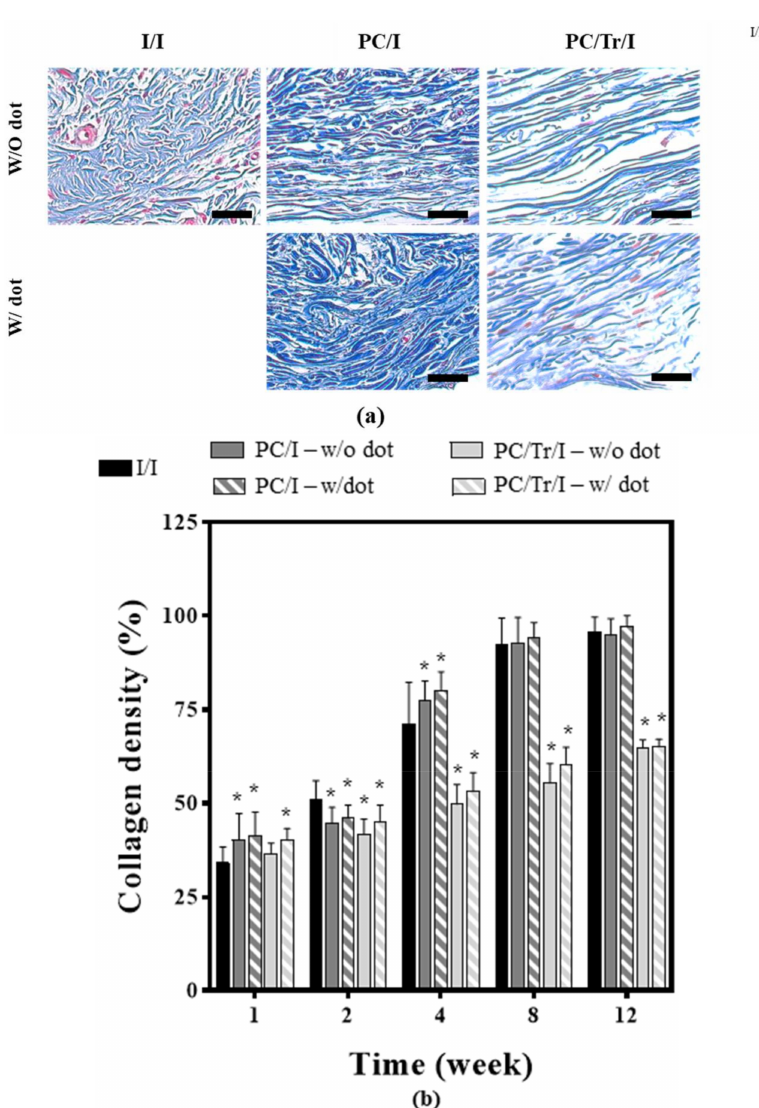
Figure 7. Evaluation of collagen density 12 weeks after sample implantation. ( a ) Representative MT-stained images observed at 12 weeks. Scale bars are 200 µ m. ( b ) Profiles of collagen density. * Statistically significant difference from the I/I (p < 0.05). Error bars are the standard